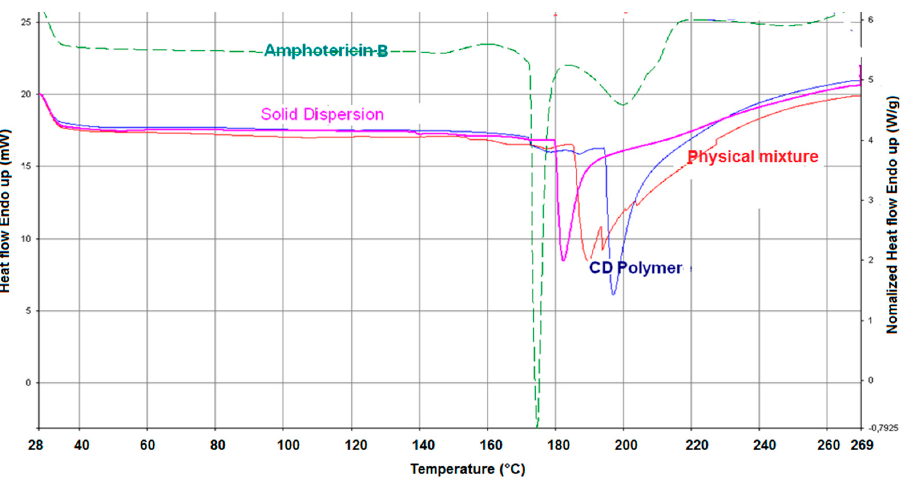
Figure 3. Thermograms of spray-dried amphotericin B (green), uncharged γ -cyclodextrin based polymer (blue), solid dispersion with AmB (purple) and physical mixture of γ -cyclodextrin based polymer with AmB (red).